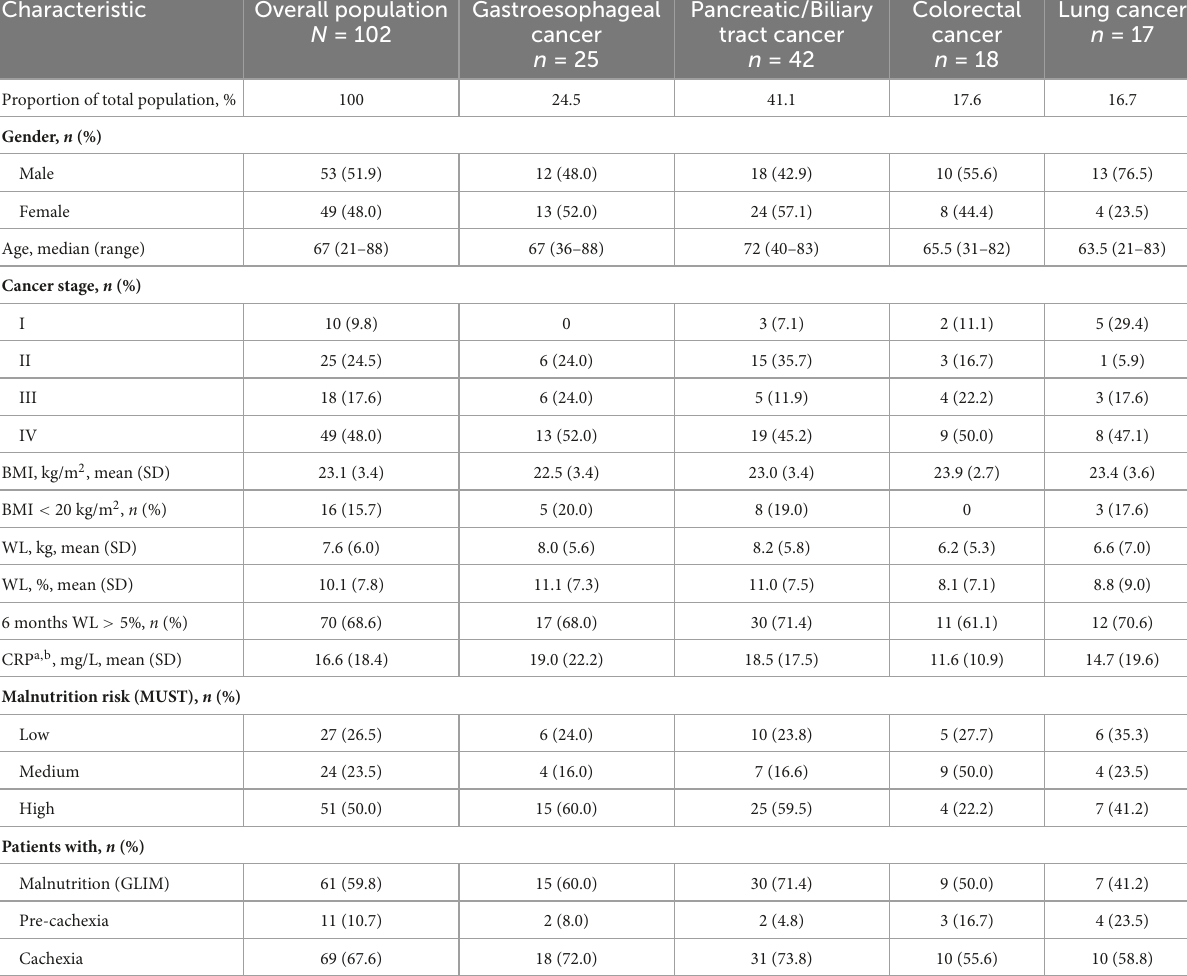
TABLE 1 Demographic and clinical characteristics at